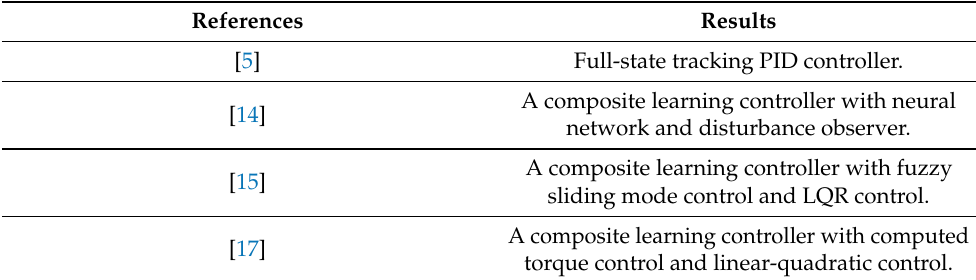
Table 2. The optimal control feedback gains with varying